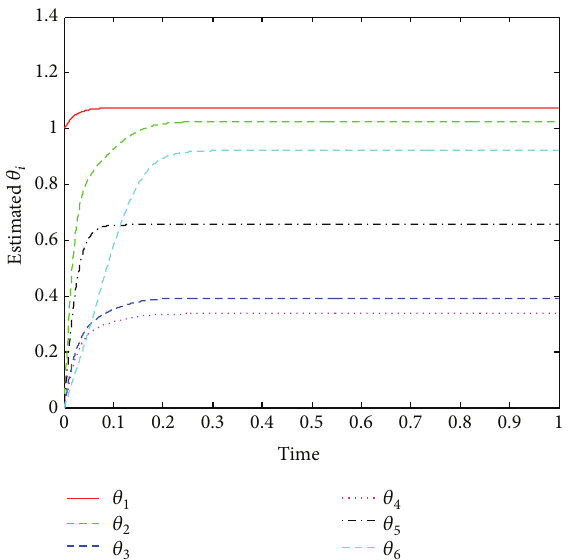
Figure 5: The evaluations of parameters 𝑀 1𝑖 (𝑡) . solved via distributed adaptive control method. The adaptive strategies are concerned with the networks topology. By com- bining inequality techniques and the parameter separation, introducing the composite energy function, the convergence of the tracking error and the boundedness of the system signals are derived. Moreover, the coupling matrix is not assumed to be symmetric or irreducible. Finally, a typical example was simulated to verify the proposed theoretical